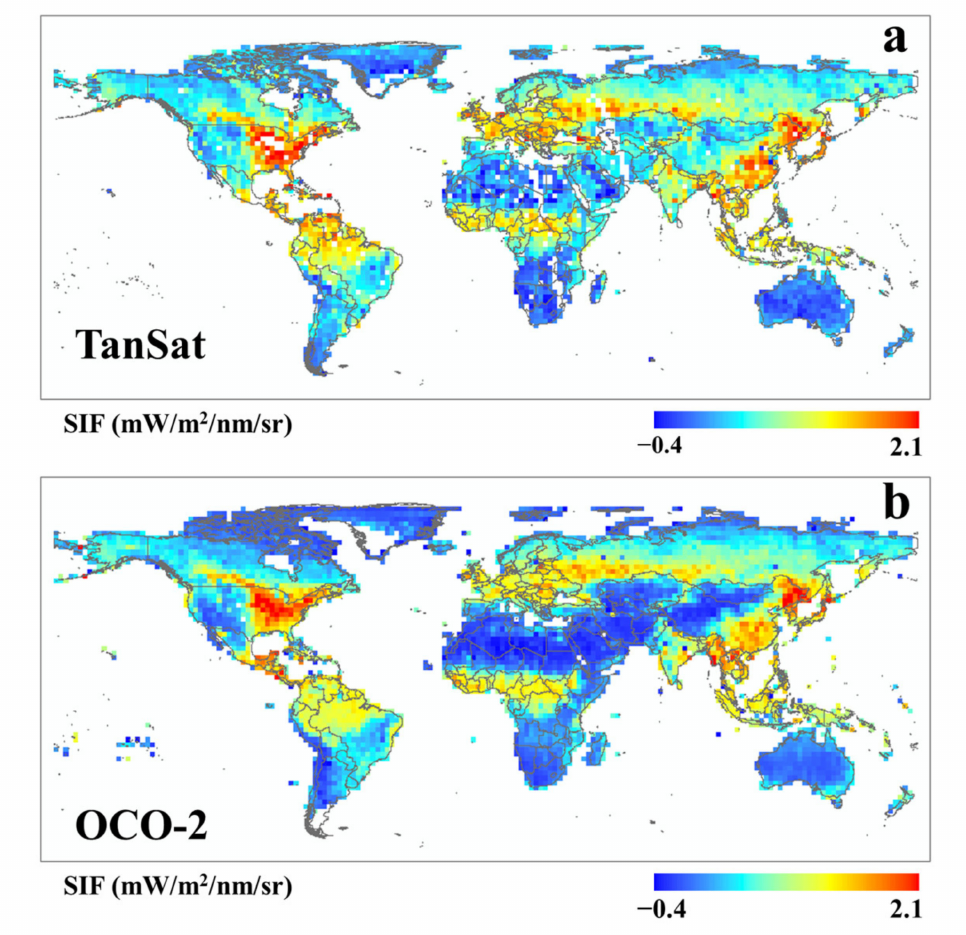
Figure 4. Global map of TanSat SIF 758 ( a ) and OCO-2 SIF 758 ( b ) in July 2017, with a cell resolution of 2 ◦ × 2 ◦